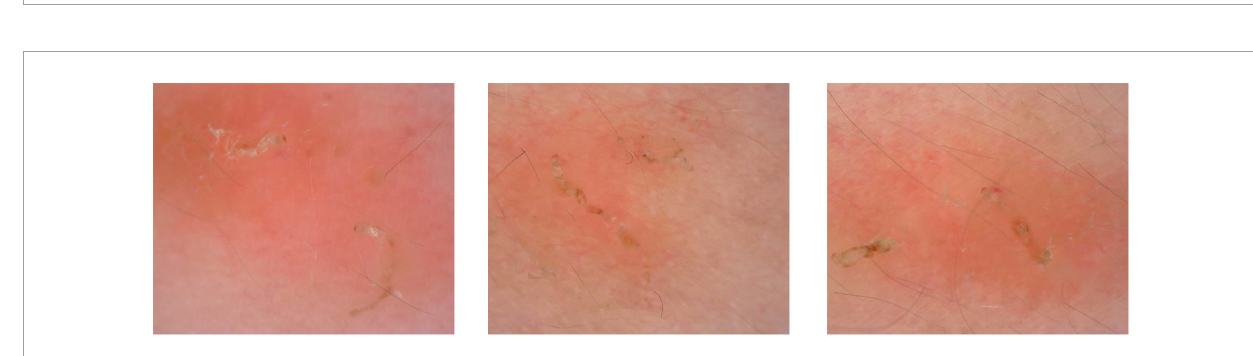
FIGURE2 Multiple burrows were seen in one dermoscopic